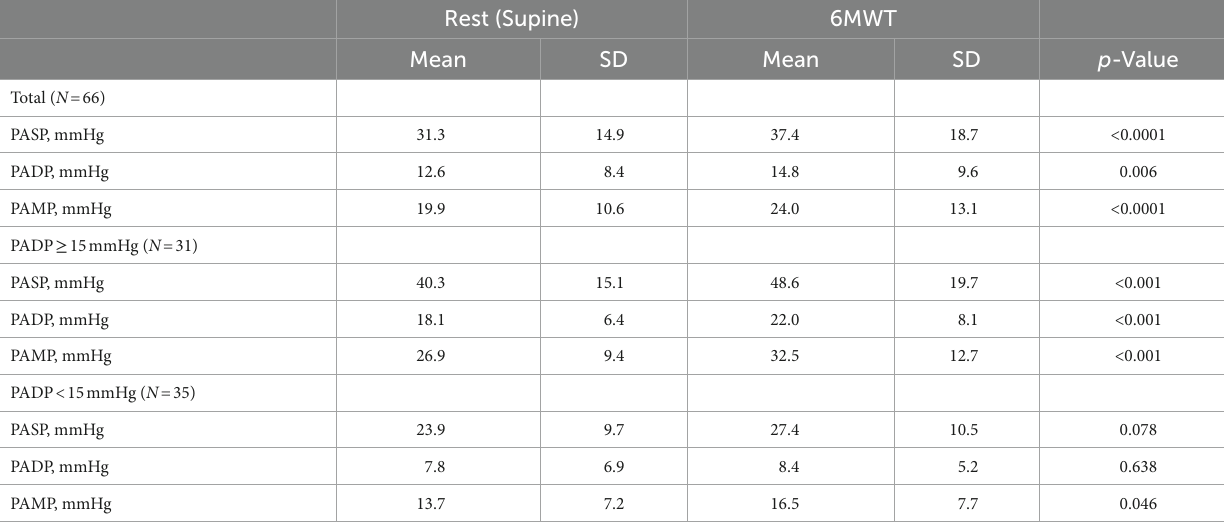
TABLE 2 Changes in pulmonary pressures from rest to post-exercise in the whole cohort and in subgroups with elevated and normal pulmonary artery diastolic pressure in the supine position.